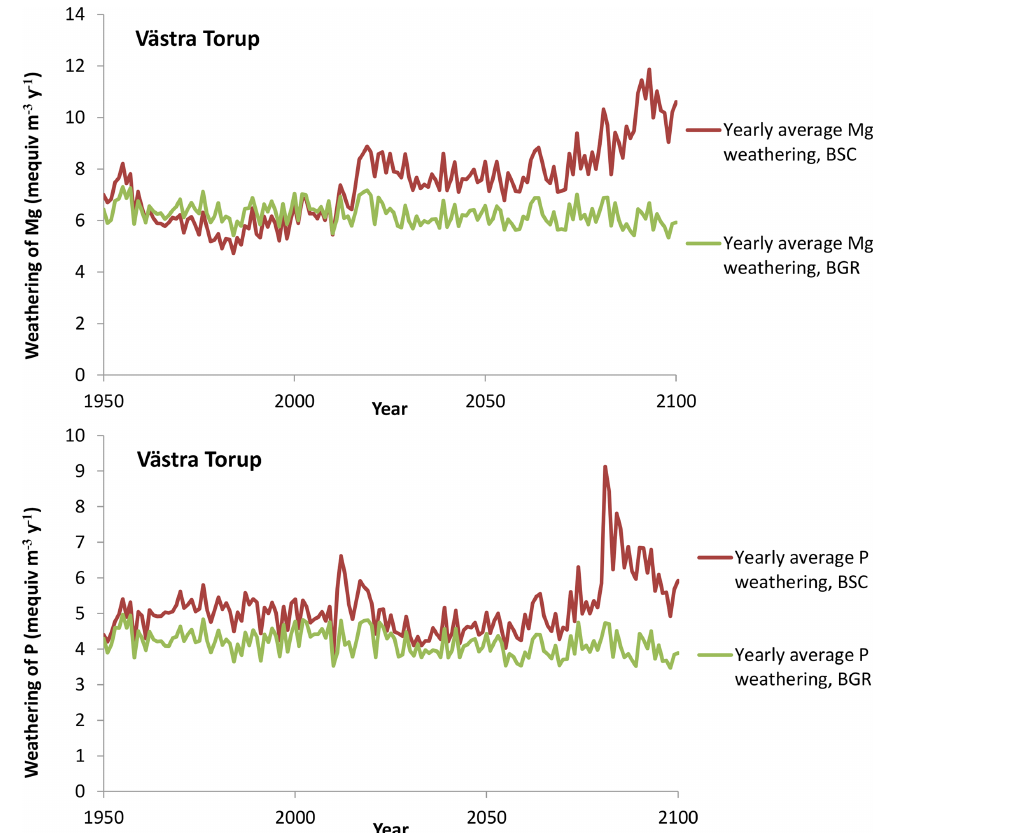
Figure 7. Weathering of Mg (from silicates) and P (from apatite) at Västra Torup, under the BSC scenario and the BGR scenario with neither acidification or climate change nor